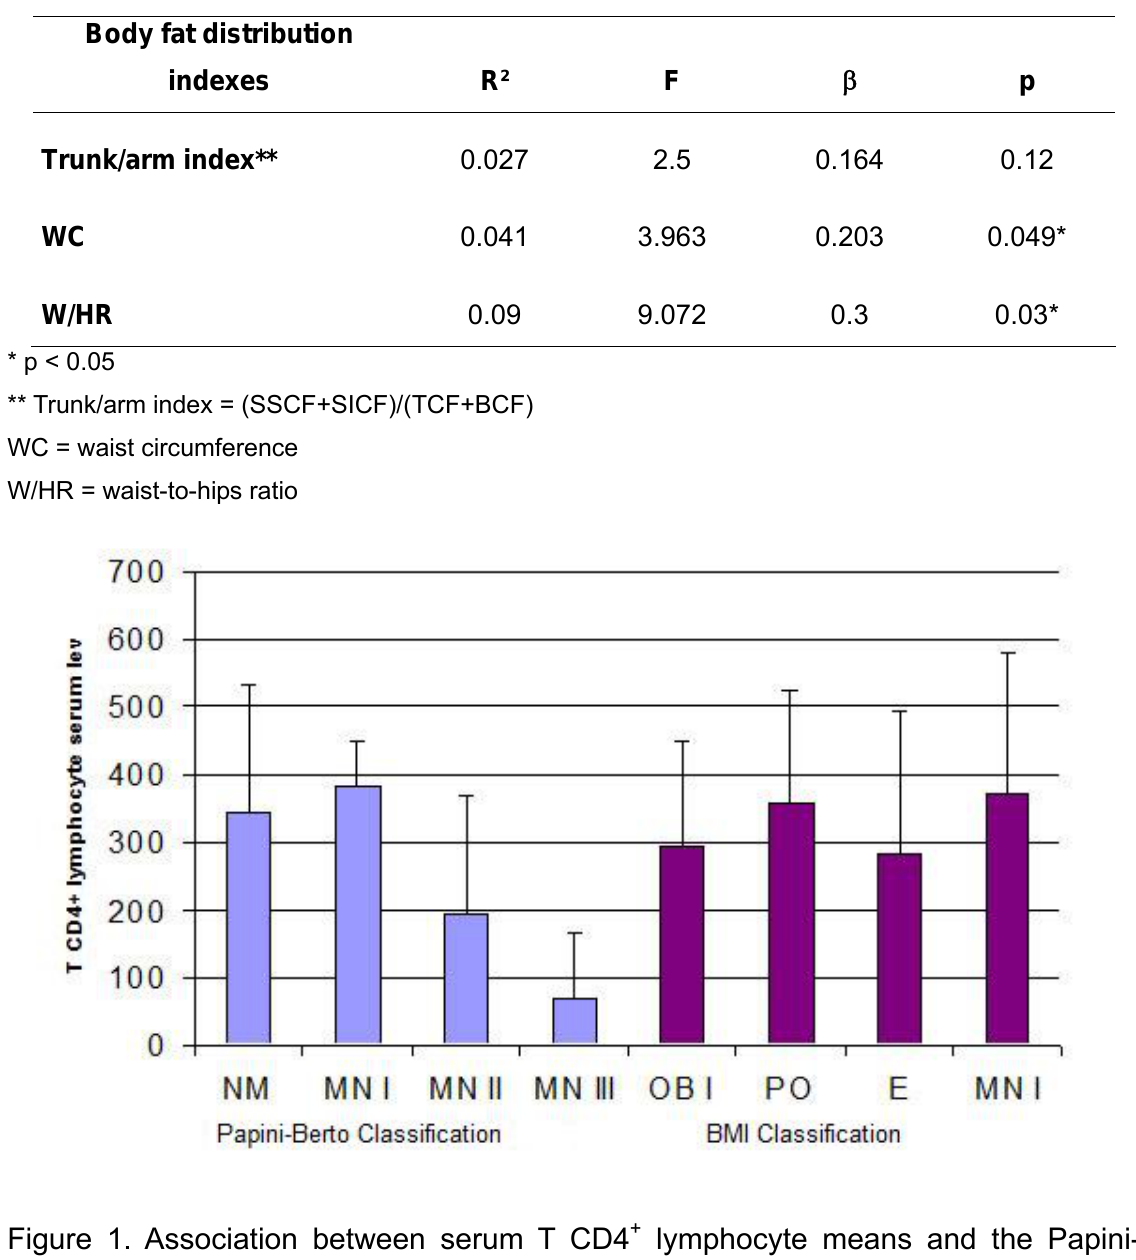
Figure 1. Association between serum T CD4 + lymphocyte means and the Papini- Berto and BMI nutritional classifications of 94 HIV-positive individuals undergoing HAART and assisted at the Nutrition and Tropical Diseases Outpatient Hospital, Botucatu Medical School - São Paulo State University (FMB - UNESP), 2003/04. (NM = non-malnourished; MN I = mild malnourishment; MN II = moderate malnourishment; MN III = severe malnourishment; OB I = level-I obesity; PO = pre- obesity; E =